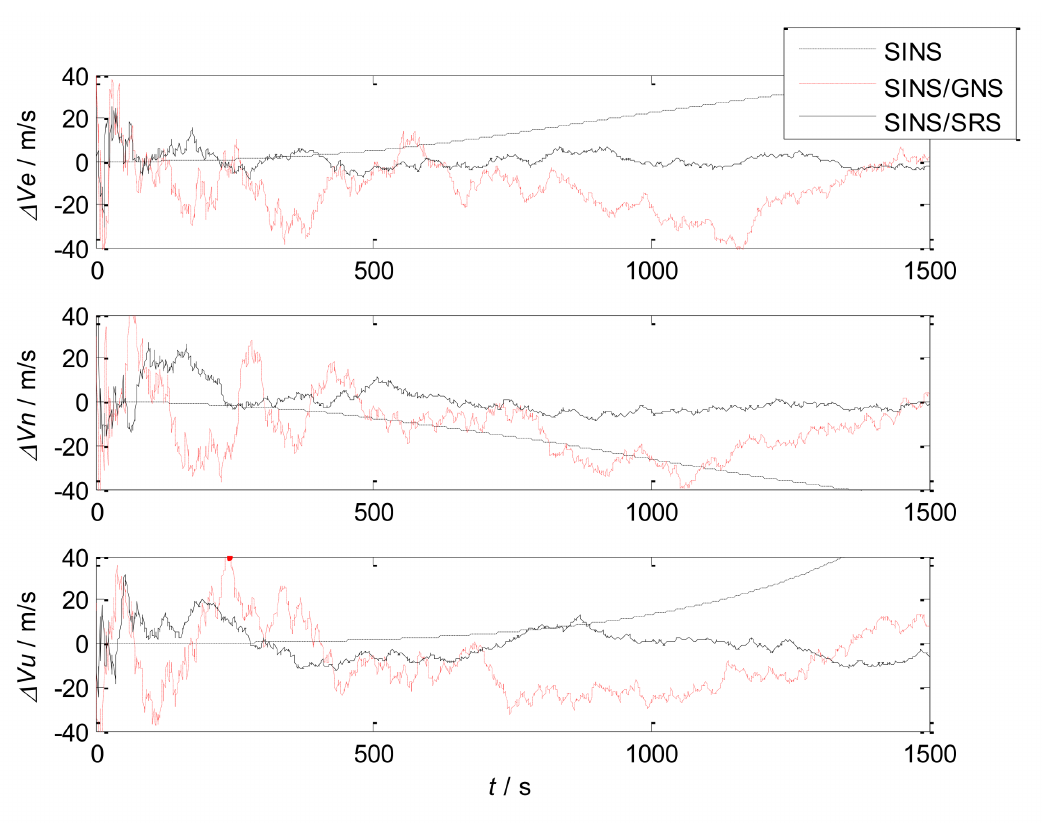
Figure 4. Velocity errors of the